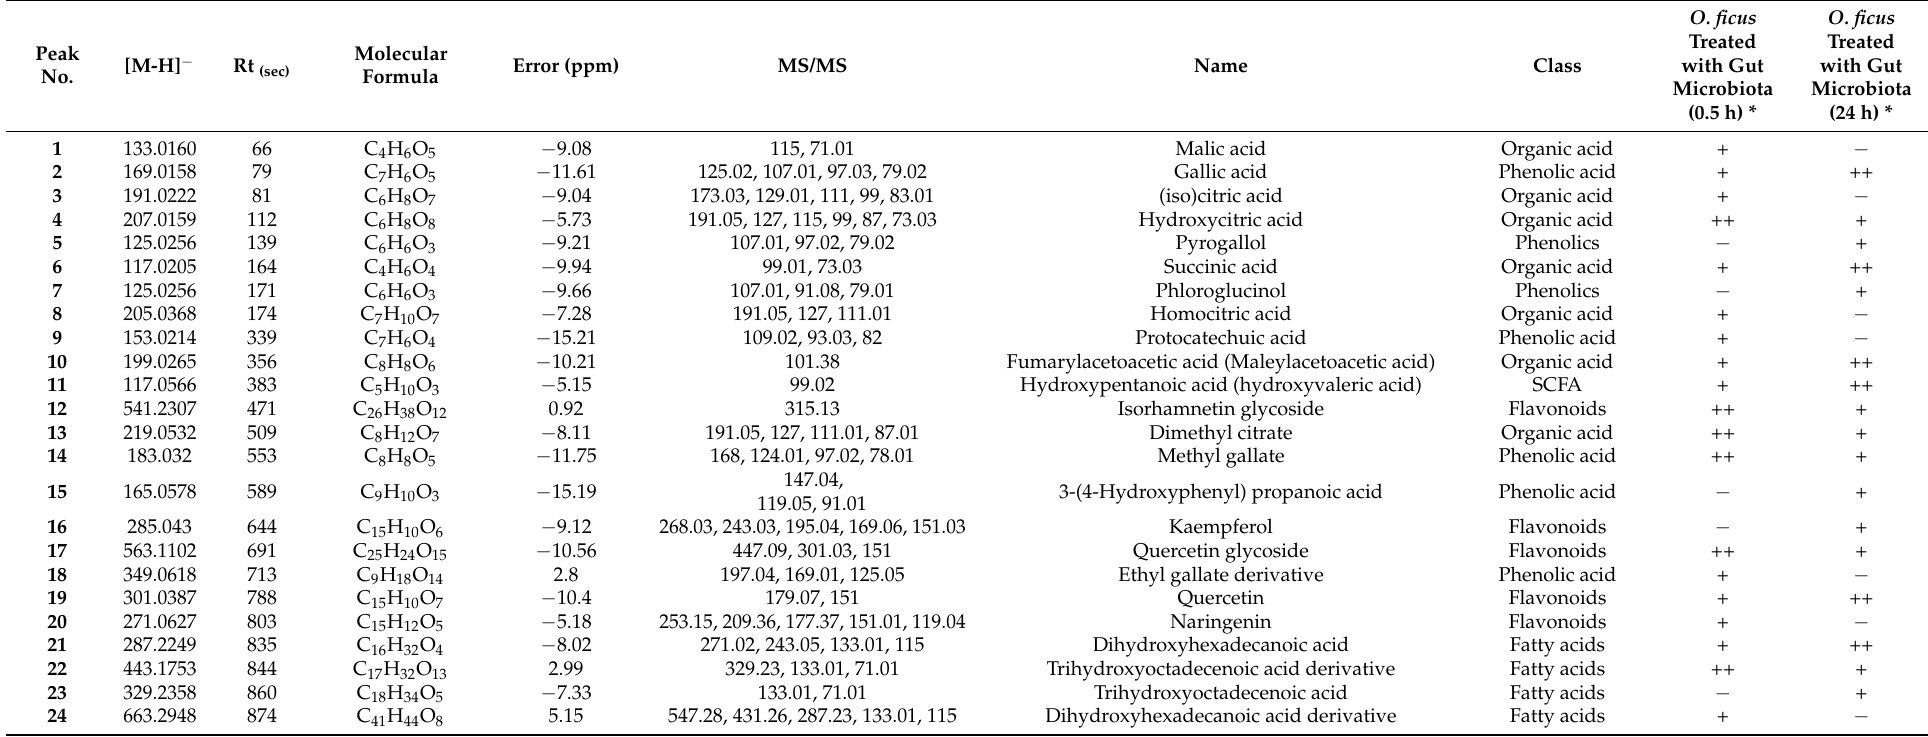
Table 1. Metabolites identified using high-resolution UHPLC-QTOF-MS in O. ficus samples treated with gut microbiota at two time intervals, 0.5 and 24 h, along with their relative